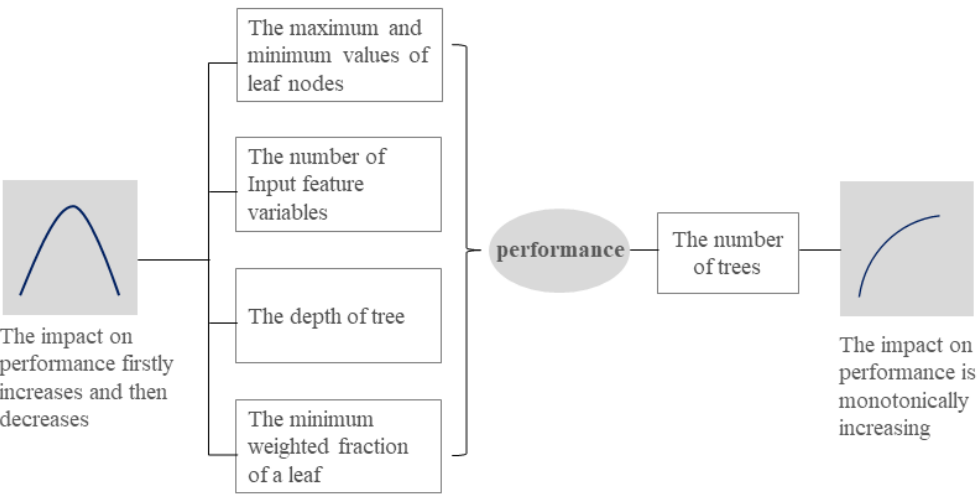
Figure 4. Influence of ETR algorithm parameters on performance.